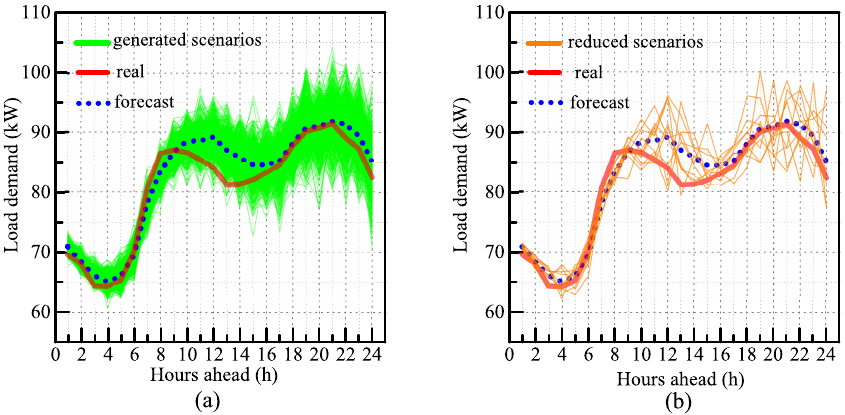
Figure 5. Scenario generation and reduction of aggregated load demand ( a ) generated 500 load scenarios for 24 h ahead with increasing standard deviation; ( b ) reduced set of 10 final scenarios by applying the BRA algorithm on the original 500